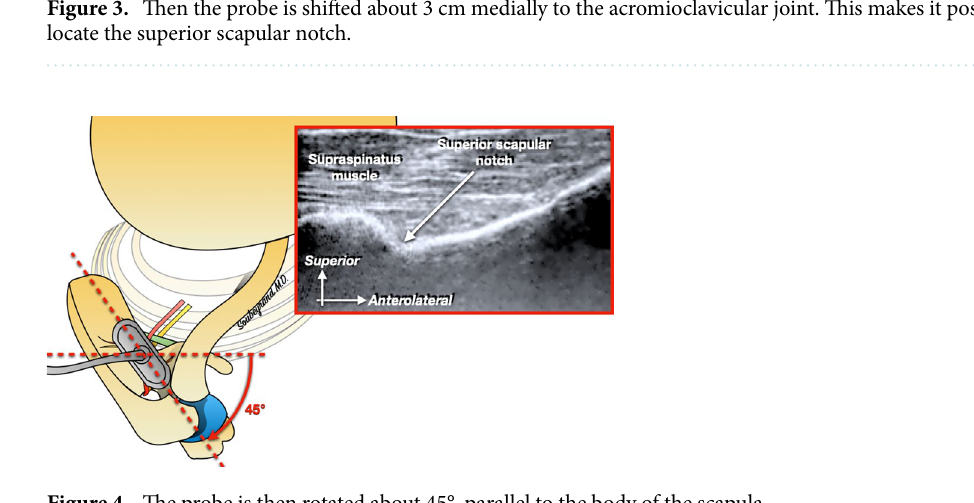
Figure 4. The probe is then rotated about 45°, parallel to the body of the